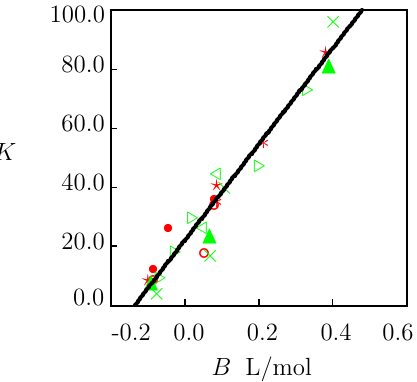
Figure 8. Parameter K versus viscosity B -coefficient of salts in aqueous solutions. Symbols: treatment of experimental data (re( D )—PNIPAAm gels, green—solutions of PNIPAAm chains) —[42], (cid:63) —[41], (cid:47) —[43], (cid:46) —[11], (cid:78) —[45], ∗